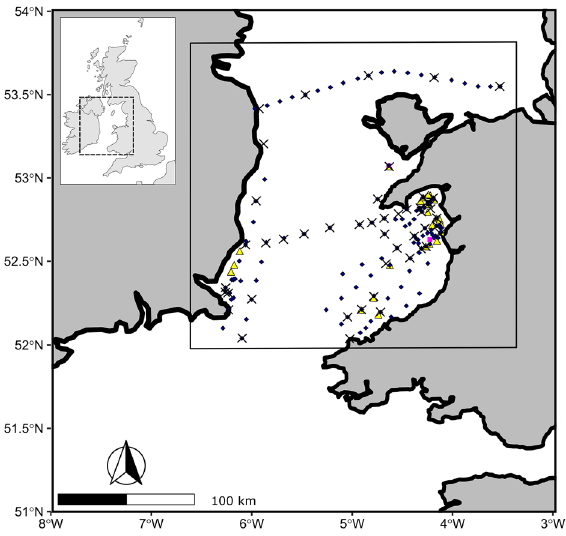
Figure 2. Cruise track in May 2008 showing locations for MIK net (pink squares), Otter trawl (yellow triangles), ring net (dark blue diamonds) and CTD casts (red